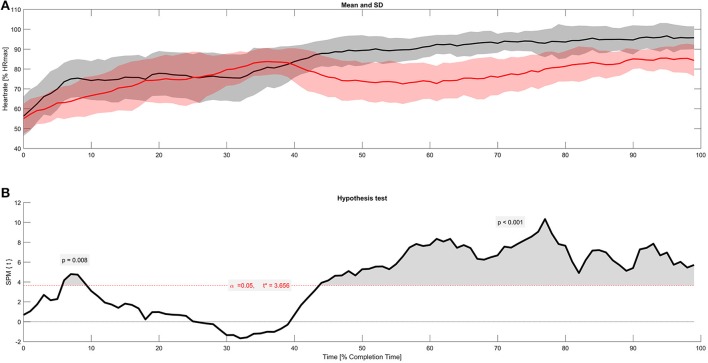
1D-SPM analyses (A) Kinetics of HR of all 16 subjects during SFE and FOT, taken as the average value of % of HRmax (± SD) and normalized on subject's individual completion time (B) 1D-SPM trajectory resulting from 1D-SPM statistics retaining a family-wise error rate of α = 0.05. The critical threshold was at t = 3.656.